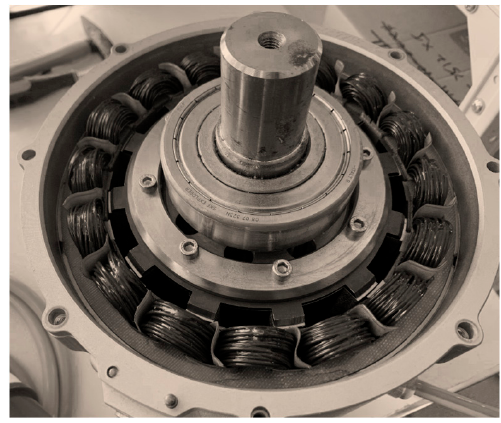
Figure 7. Prototype of SRM electric machine.